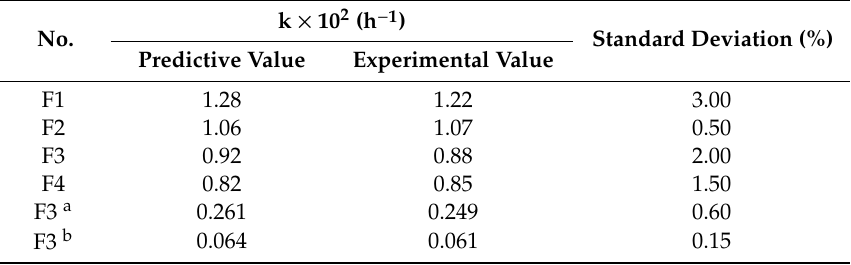
Table 4. Value of the kinetic constants and the standard deviation for the